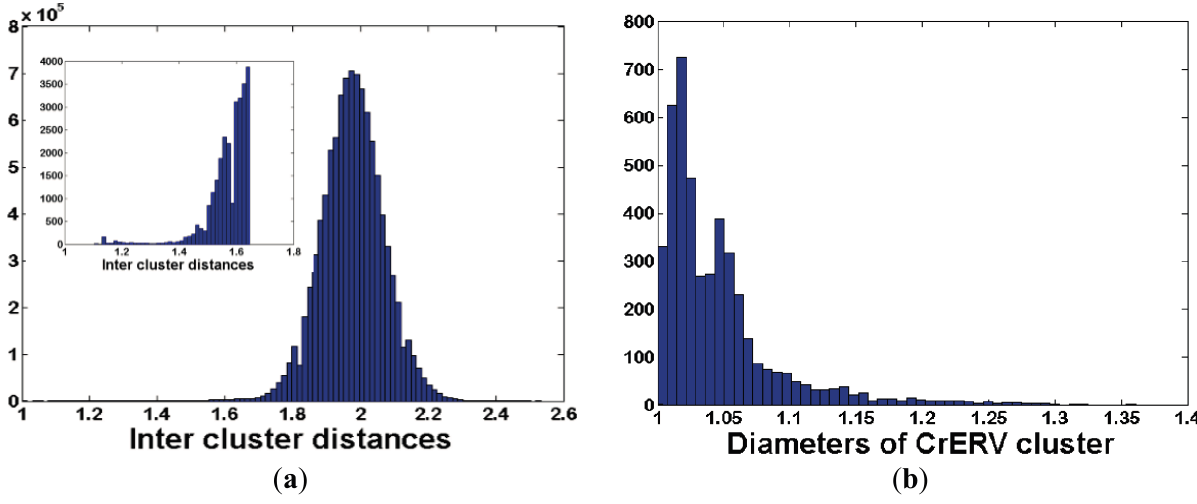
Figure 3. Features of clusters representing CrERV-host junction fragments obtained by de novo clustering. ( a ) Frequency distribution of inter-cluster distances. The x -axis is a measure of the pairwise distance between clusters and the y -axis represents the frequency of all pairwise distances for the data set of 3160 cluster consensus sequences. The pairwise distance among clusters will be small if clusters are derived from closely related sequences, e.g., from a similar repeat region, or if two sets of reads from different regions are merged. The peak in the frequency distribution near 2 in our data indicates that the sequences returned by our clustering are well separated. Inset shows an expanded scale for inter-cluster distances between 1.1 and 1.65. The threshold for combining closely related clusters was chosen as 1.2; ( b ) Frequency distribution of cluster diameters. The y -axis represents the frequency that a cluster diameter is observed and the x -axis represents cluster diameters, which are computed as the average distance of each read assigned to the cluster to the cluster consensus sequence. The majority of clusters have value close to one, indicating near perfect identity of individual reads in the cluster to the consensus